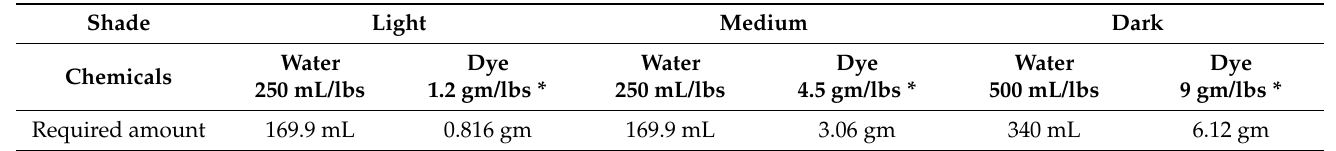
Table 3. Amount of chemicals required for preparing the dyeing solution for one batch of carpets. Corresponding batch weight ≈ 308.6